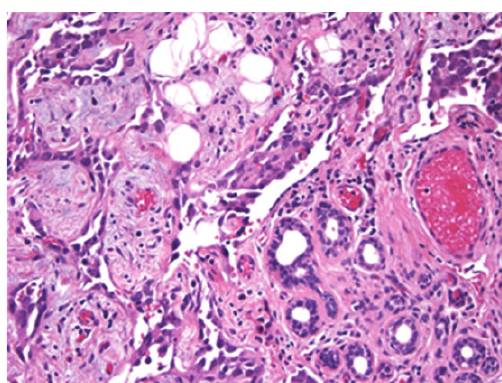
Figure6:NuclearstainingforKi-67ingreaterthanhalfthecellswas present in 40% of radiation-associated angiosarcomas, indicating very high proliferative activity (immunoperoxidase, 400x).